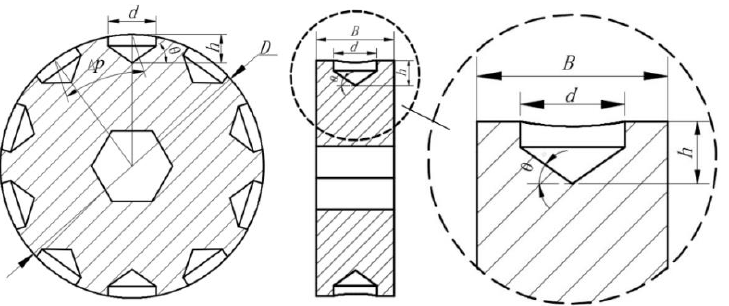
Figure 4. Structure of metering wheel. Note: D is the diameter of the metering wheel, mm; h is the hole depth, mm; θ is the cone angle of the hole, ◦ ; ∆ p is the distance between adjacent holes, mm; B is hole depth, mm; θ is the cone angle of the hole, °; ∆𝑝 is the distance between adjacent holes, mm; B is the thickness of metering wheel, mm. the thickness of metering wheel,